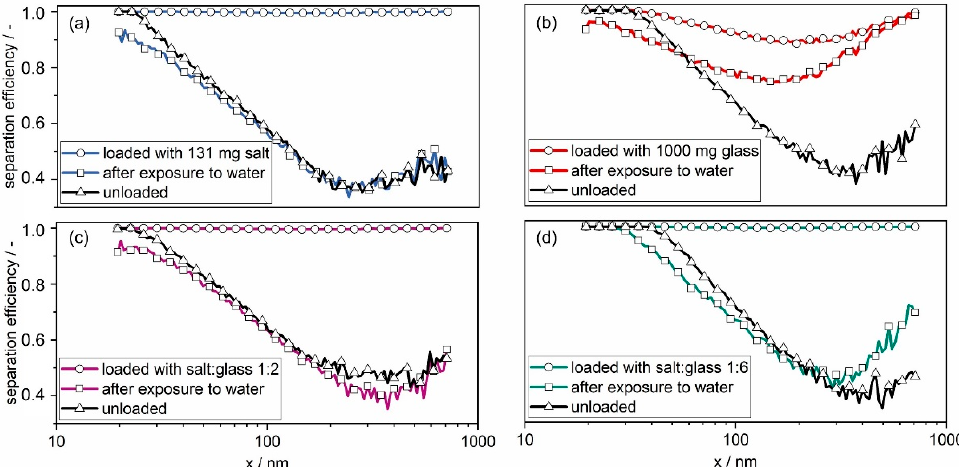
Figure 16. Fractional separation efficiencies before particle loading (unloaded), after particle loading (loaded) and after exposure to water mist of a ( a ) salt-laden, ( b ) glass-laden, ( c ) salt–glass-laden 1:2 and ( d ) salt–glass-laden 1:6 filter. The filters containing salt are all loaded with the same salt mass of 131 mg.